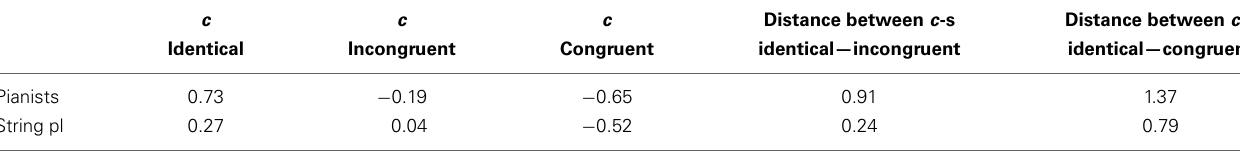
Table 3B | As in Table 3A, but for the distances and values of c